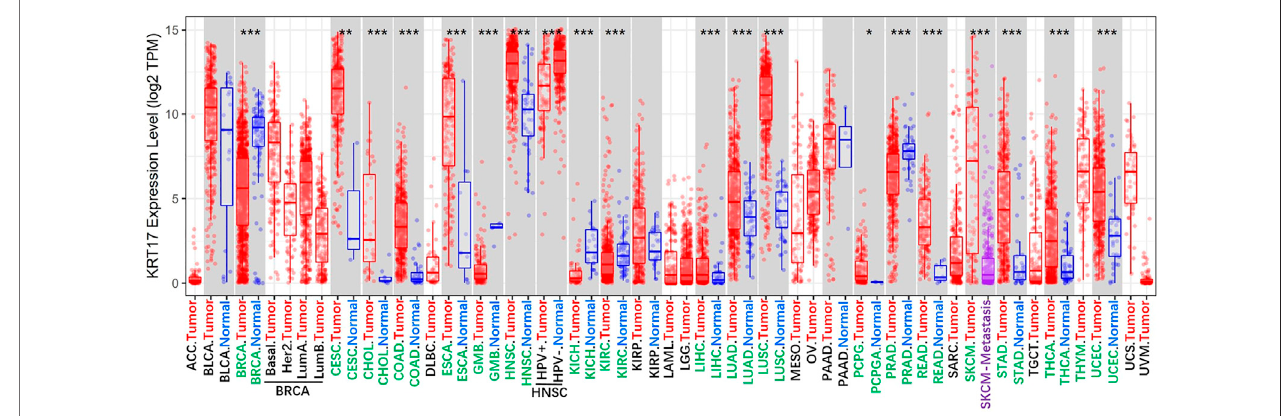
FIGURE1| TheexpressionstatusoftheKRT17in33kindsofmalignanttumourtissuesand22kindsofnormaltissues.(TCGAdataset)(http://timer.cistrome.org/) (* p < 0.05; ** p < 0 01; *** p < 0 001).